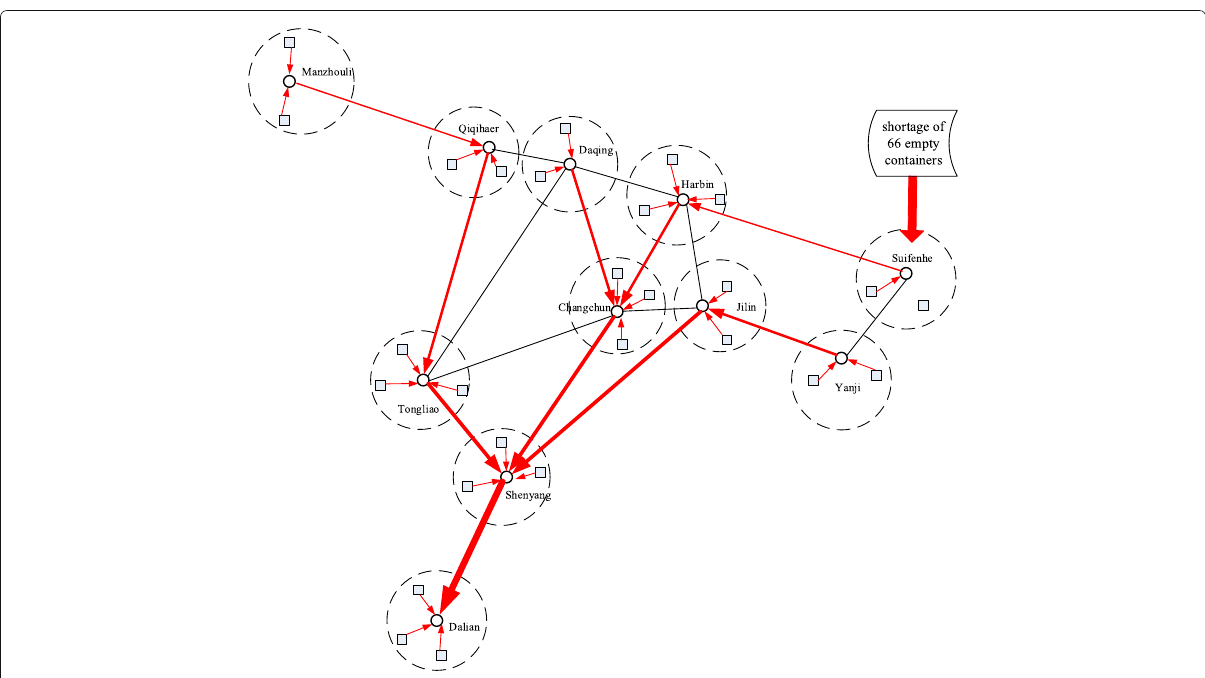
Fig. 6 Transportation of export-full containers and abandoned demand